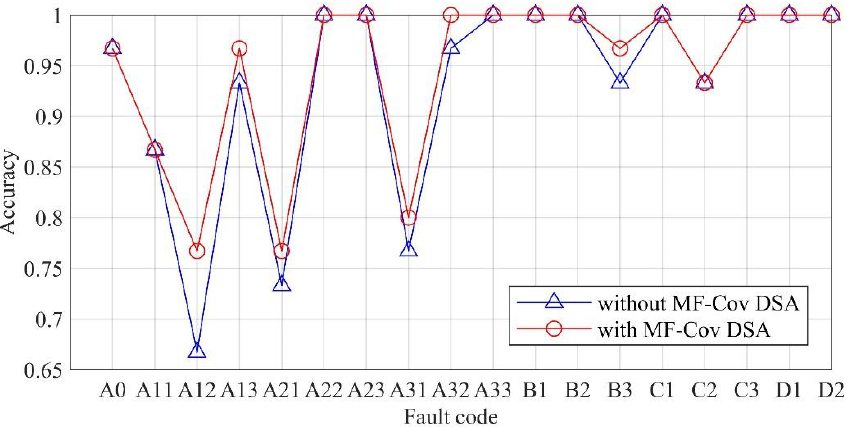
Figure 10. The diagnostic accuracy of the proposed model for each fault with and without MF-Cov DSA module.